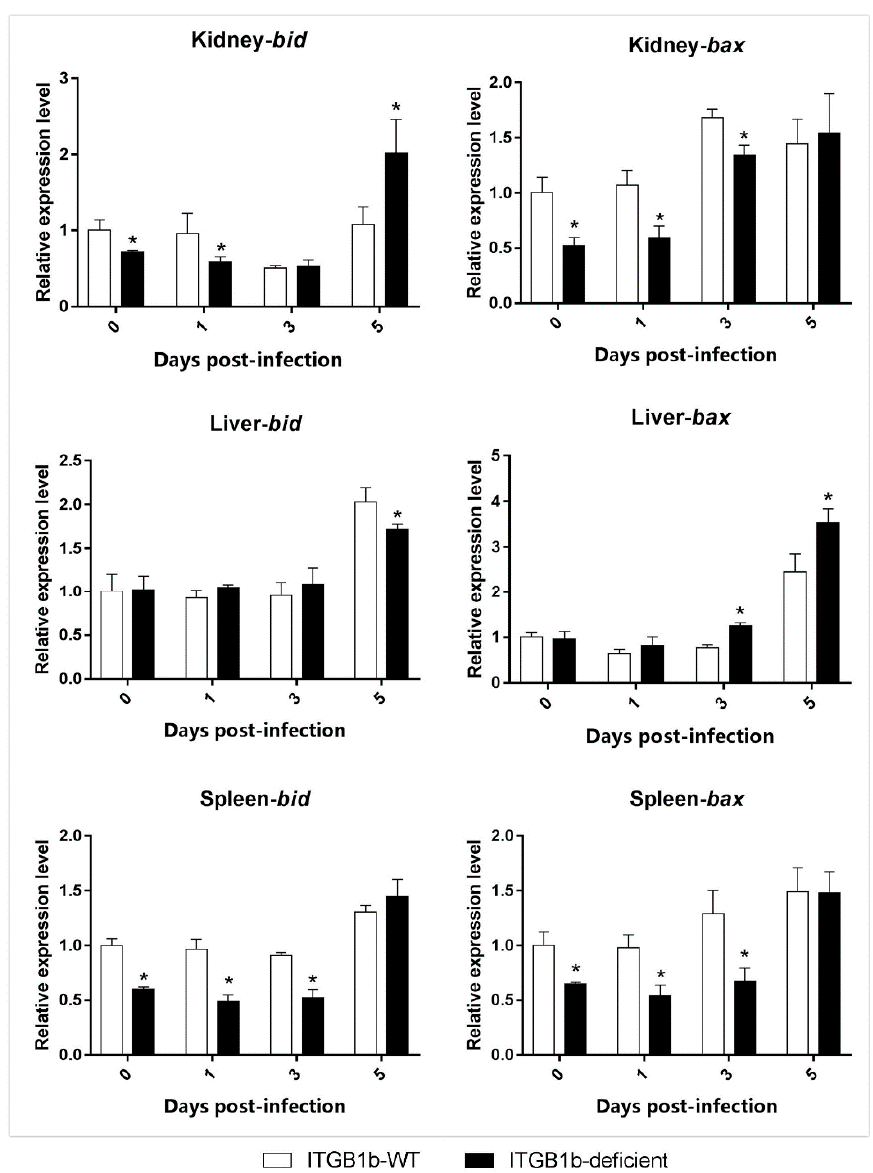
Figure 8. Expression of apoptosis-related genes in ITGB1b-deficient and wild-type rare minnows. The relative expression levels were calculated as the ratio of gene expression level in ITGB1b-deficient fish relative to that in wild-type fish at 0 dpi. A significant difference ( p < 0.05, ANOVA) in gene expression level between the wild-type and ITGB1b-deficient and wild-type rare minnows is indicated with an asterisk (*).